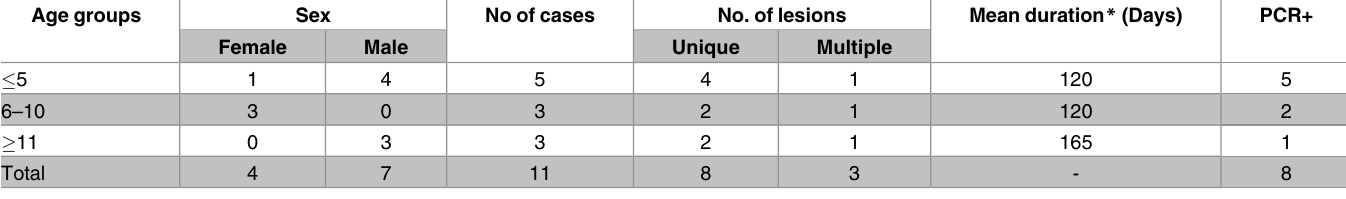
Table 3. Characteristics of active CL cases diagnosed during the study. Age